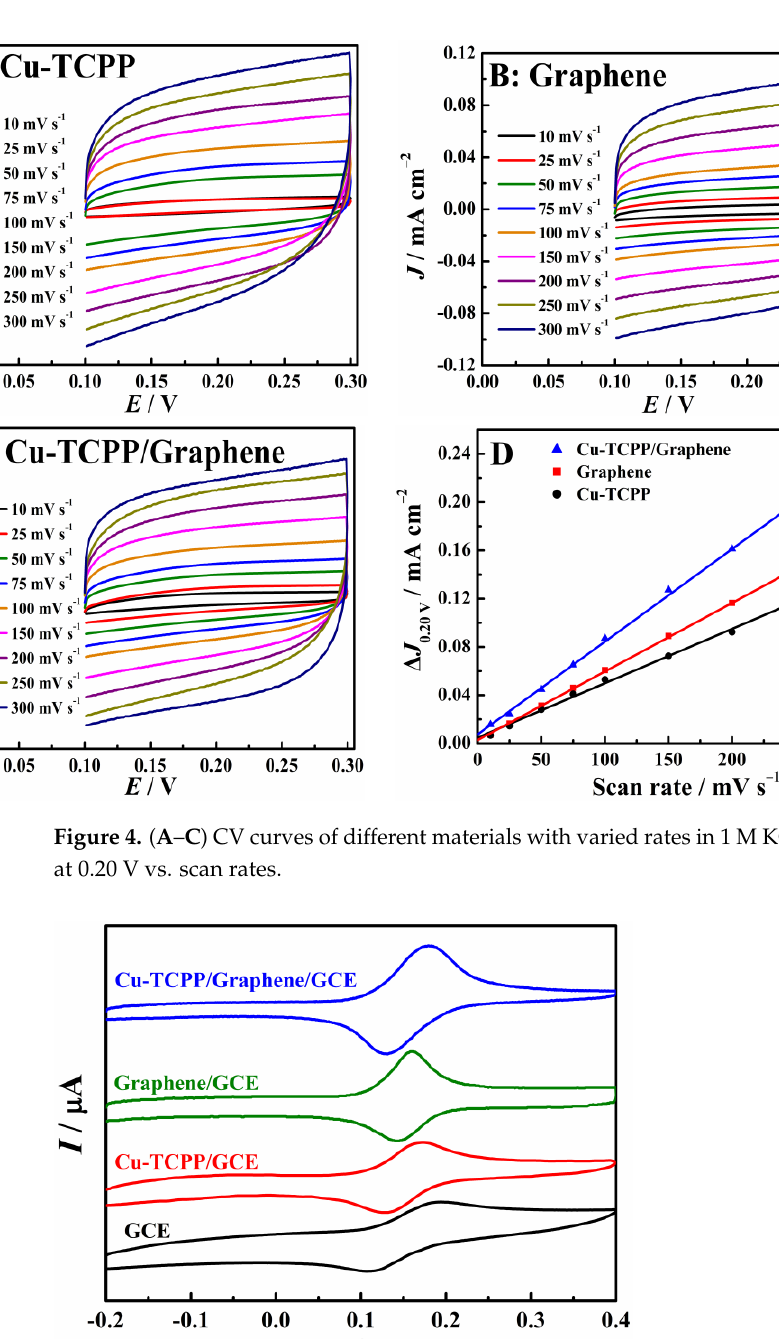
Figure 5. CV curves of different GCEs in 100 µM DA in pH 7.0 PBS.